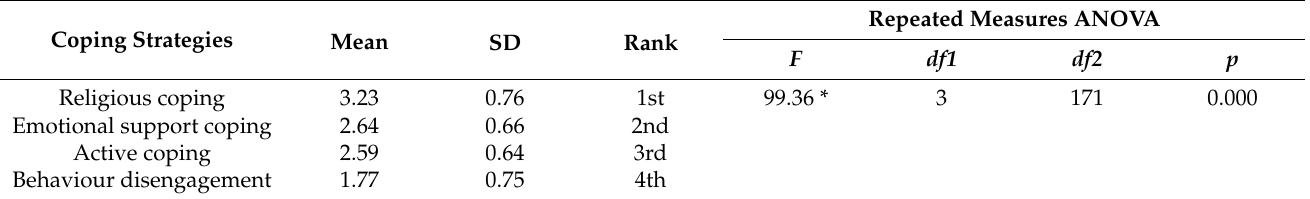
Table 3. Coping strategies adopted by teachers when teaching during the COVID-19